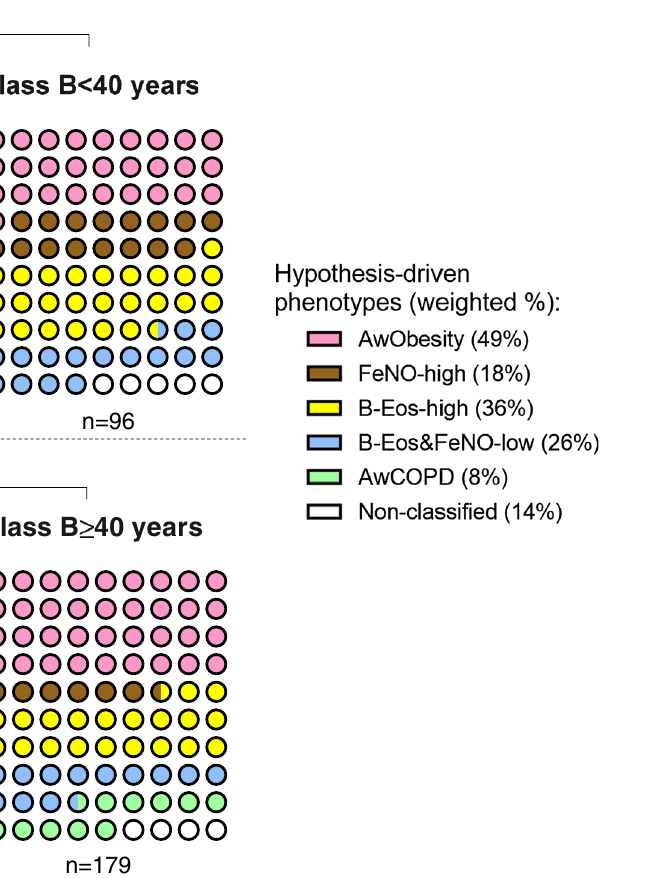
Fig. 1 Distribution of the hypothesis-driven asthma phenotypes according to the data-driven classes identified in Model 2. Both Class A < 40 and Class A 40 are the phenotypes with more asthma-related symptoms and low lung function. No significant differences (p > 0.05) were observed ≥ between the proportions of the hypothesis-driven within the data-driven phenotypes. NS